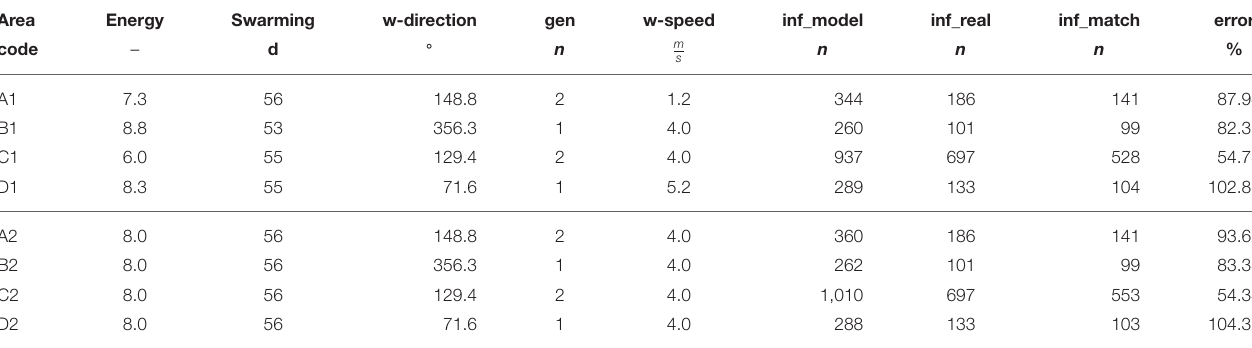
The corresponding results of one model run with the respective parameter values can be found in Figure 4 . w-direction, wind direction; gen, generations; w-speed, wind speed; inf_model, number of infested trees within the model; inf_real, number of infested trees in the real world; inf_match, number of infested trees in the model that match the real world data.